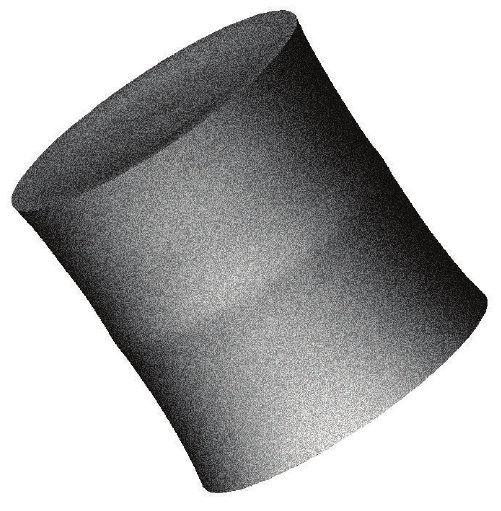
Figure 2: 3D CANDU pellet calculated with BaCo + MeCom Tools. Radial deformations are